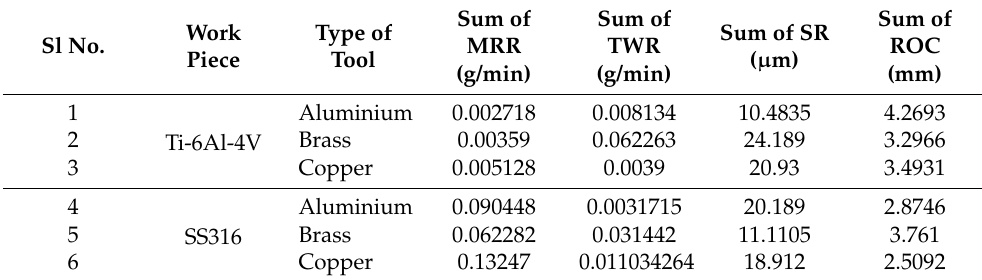
Table 12. Sum of the values of output parameters.